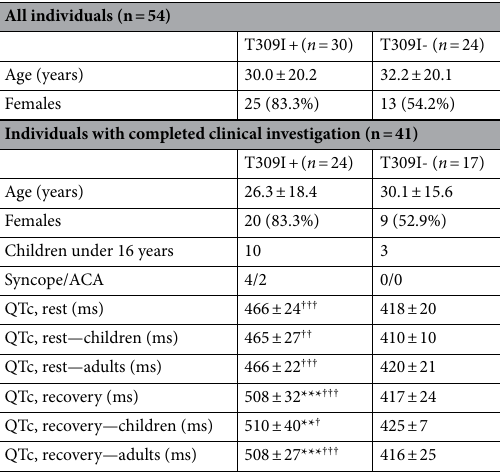
Table 1. Clinical characteristics of investigated individuals, members of 10 unrelated families. T309I + , T309I carriers; T309I-, T309I non-carriers; mean ± SD, n —number of individuals; QTc, QT interval corrected to the heart rate (Bazett´s formula); QTc, recovery, QTc, 4th minute of the recovery phase after ergometry; ACA, aborted cardiac arrest; statistics in the respective groups of patients (all/children/adults): ** and ***—statistical significance of QTc difference at rest and during recovery at P < 0.01 and 0.001, respectively, † , †† and ††† — statistical significance of the respective QTc difference between T309I + and T309I- at P < 0.05, 0.01 and 0.001,